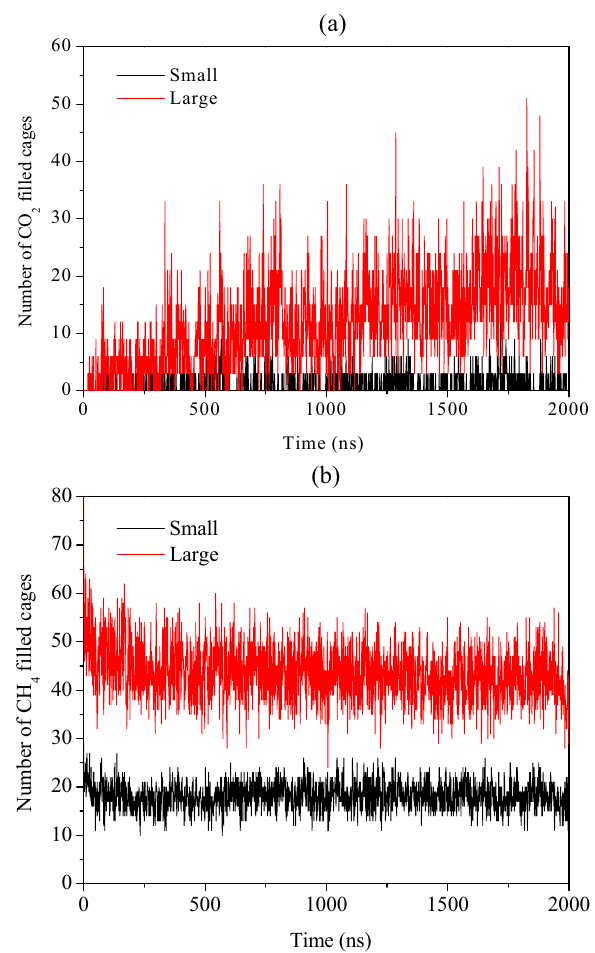
Figure 3. Plot of number of filled cages of ( a ) CO 2 and ( b ) CH 4 hydrates during the CH 4 –CO 2 replacement dynamics in absence of free water molecules with operating pressure and temperature of 50 MPa and 260 K,